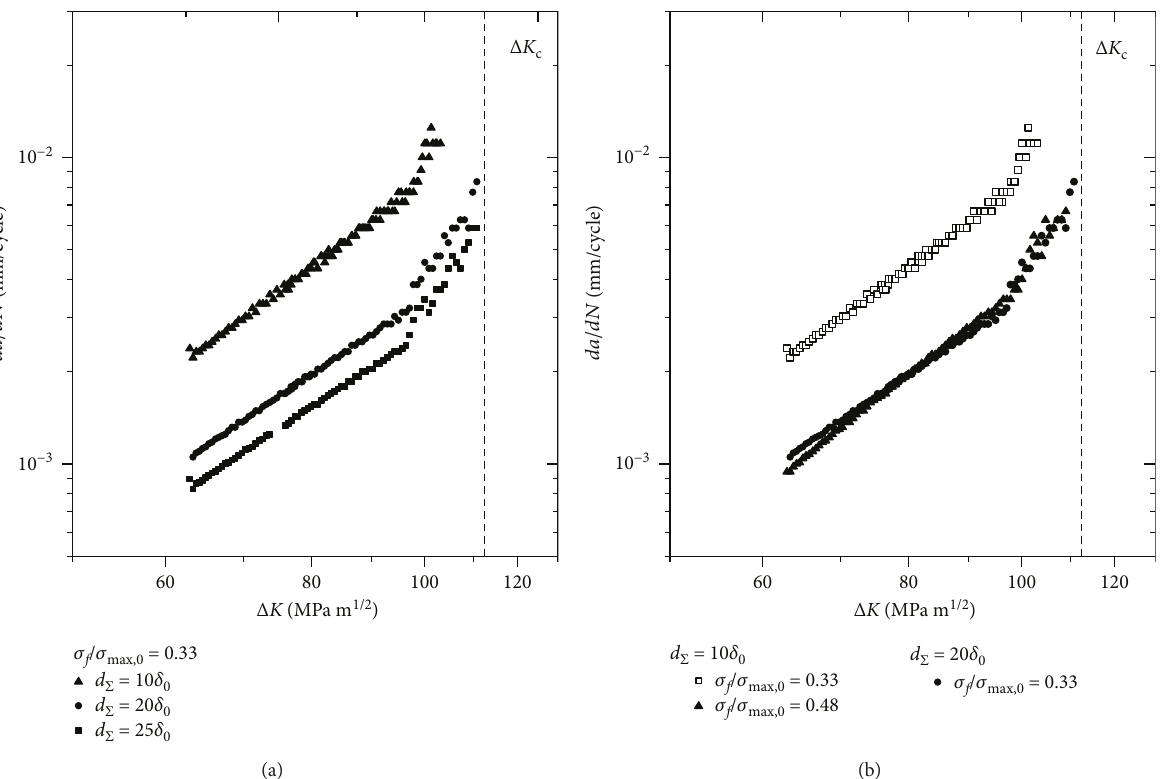
σ / σ Σ and (b) f max,0 on the fatigue crack growth rate. The constant loading amplitude is